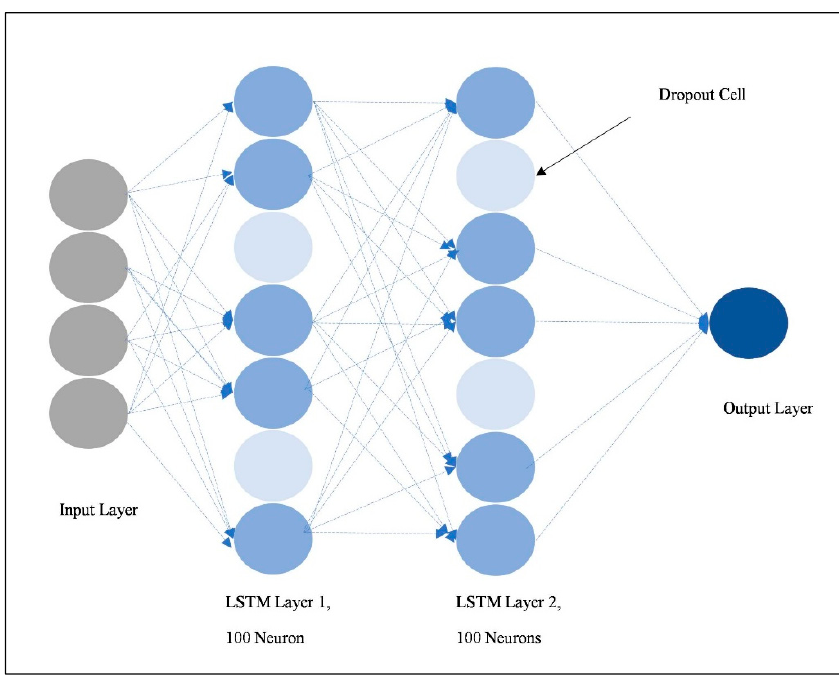
Figure 4. LSTM Network with Dropout Cells.